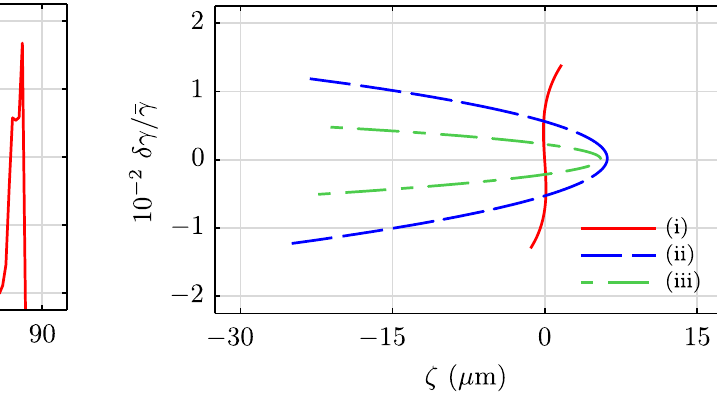
order.FIG. 3. Phase scan of the gun cavity. For case (i), an expanding FIG. 5. Comparison of the calculated phase space distributions phase is chosen, while for the comparisons (ii,iii) the maximum in the focus for cases (i,ii,iii). Cases (ii,iii) are clearly limited by the 0 , is accelerating phase, ϕ second order in contrast to scenario (i), which is much shorter. It is G ¼ almost a straight, upright line with a signature of the third